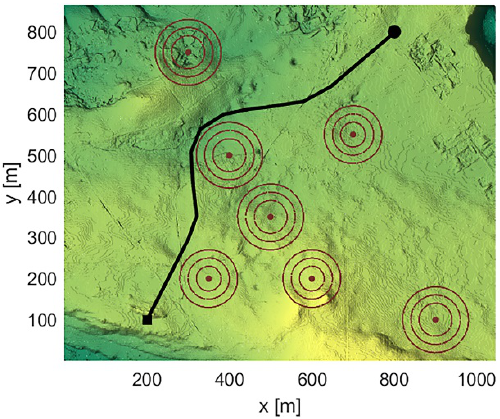
Figure 5. Top view of the path generated by the VAINDIWPSO algorithm.